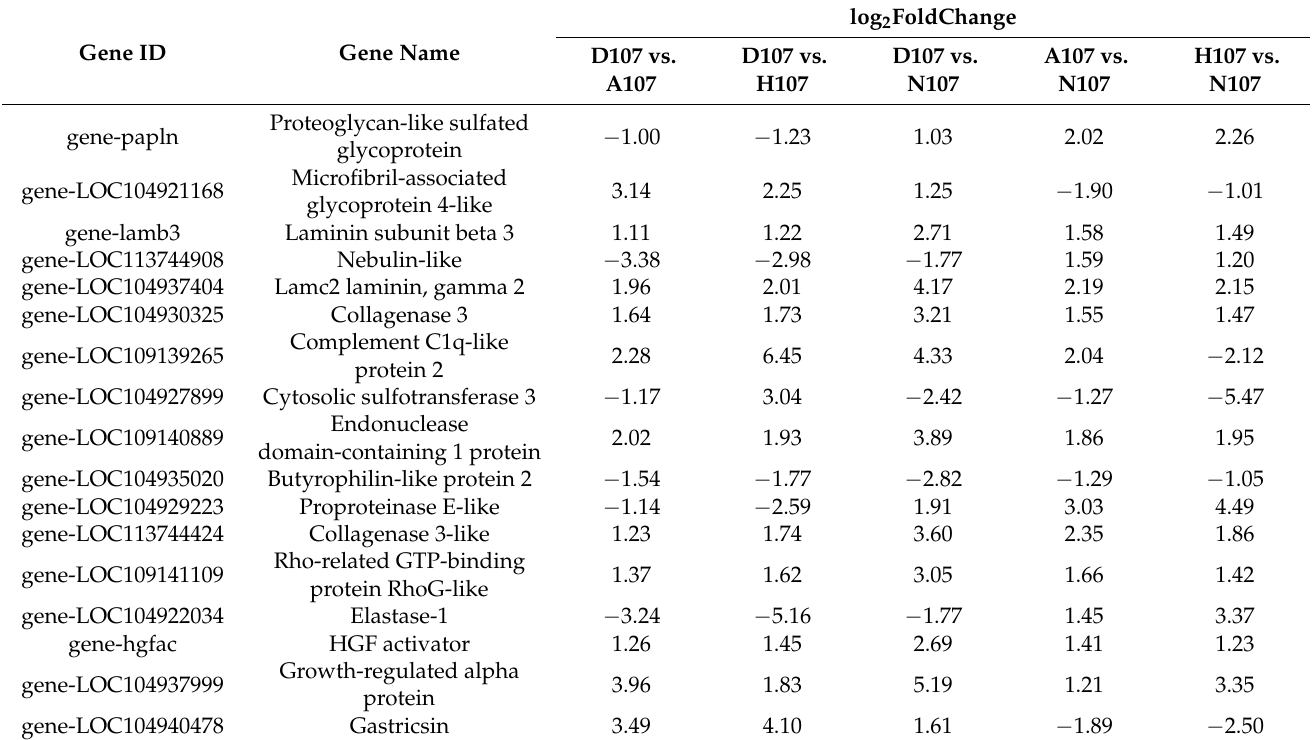
Table 2. Comparative analysis of the 17 DEGs and their expression in the different